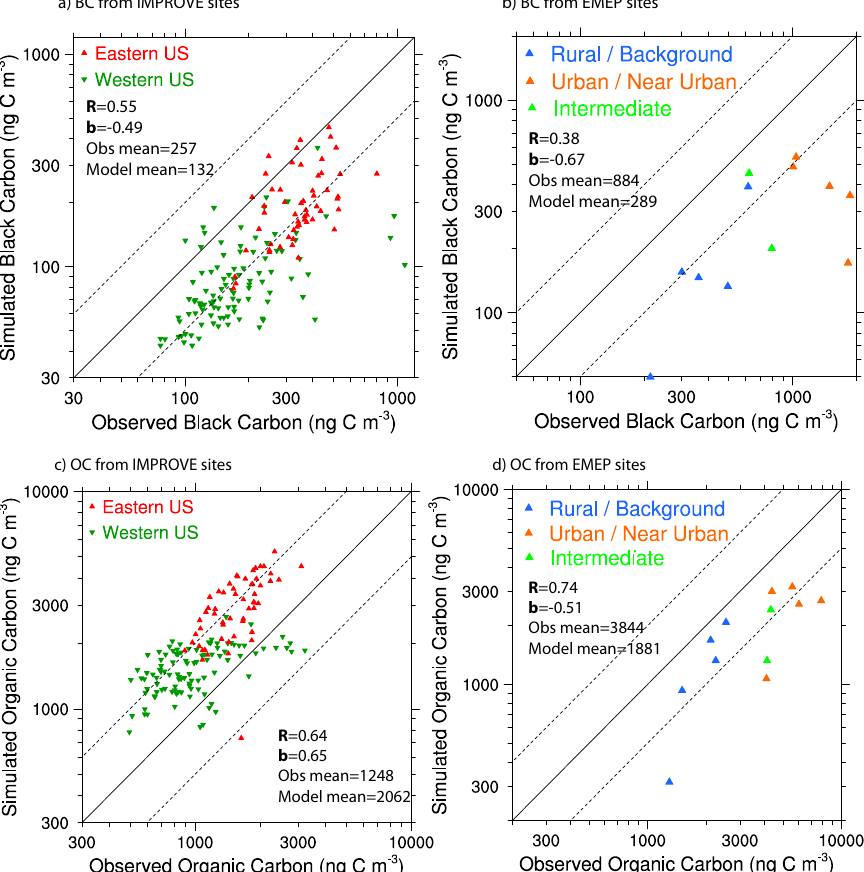
Fig. 11. Annual average simulated surface BC and OC concentrations versus observations from the IMPROVE network and EMEP network. (a) BC concentrations at the IMPROVE sites; (b) BC concentrations at the EMEP sites; (c) OC concentrations at the IMPROVE sites; (d) OC concentrations at the EMEP sites. An OC/OM ratio of 1.4 is used to convert simulated OM (POM+SOA) to OC. Model mean (“Model mean”), observational mean (“Obs mean”), normalized model mean bias (“b”) and the correlation coefficient between model and observations (“R”) are shown in each